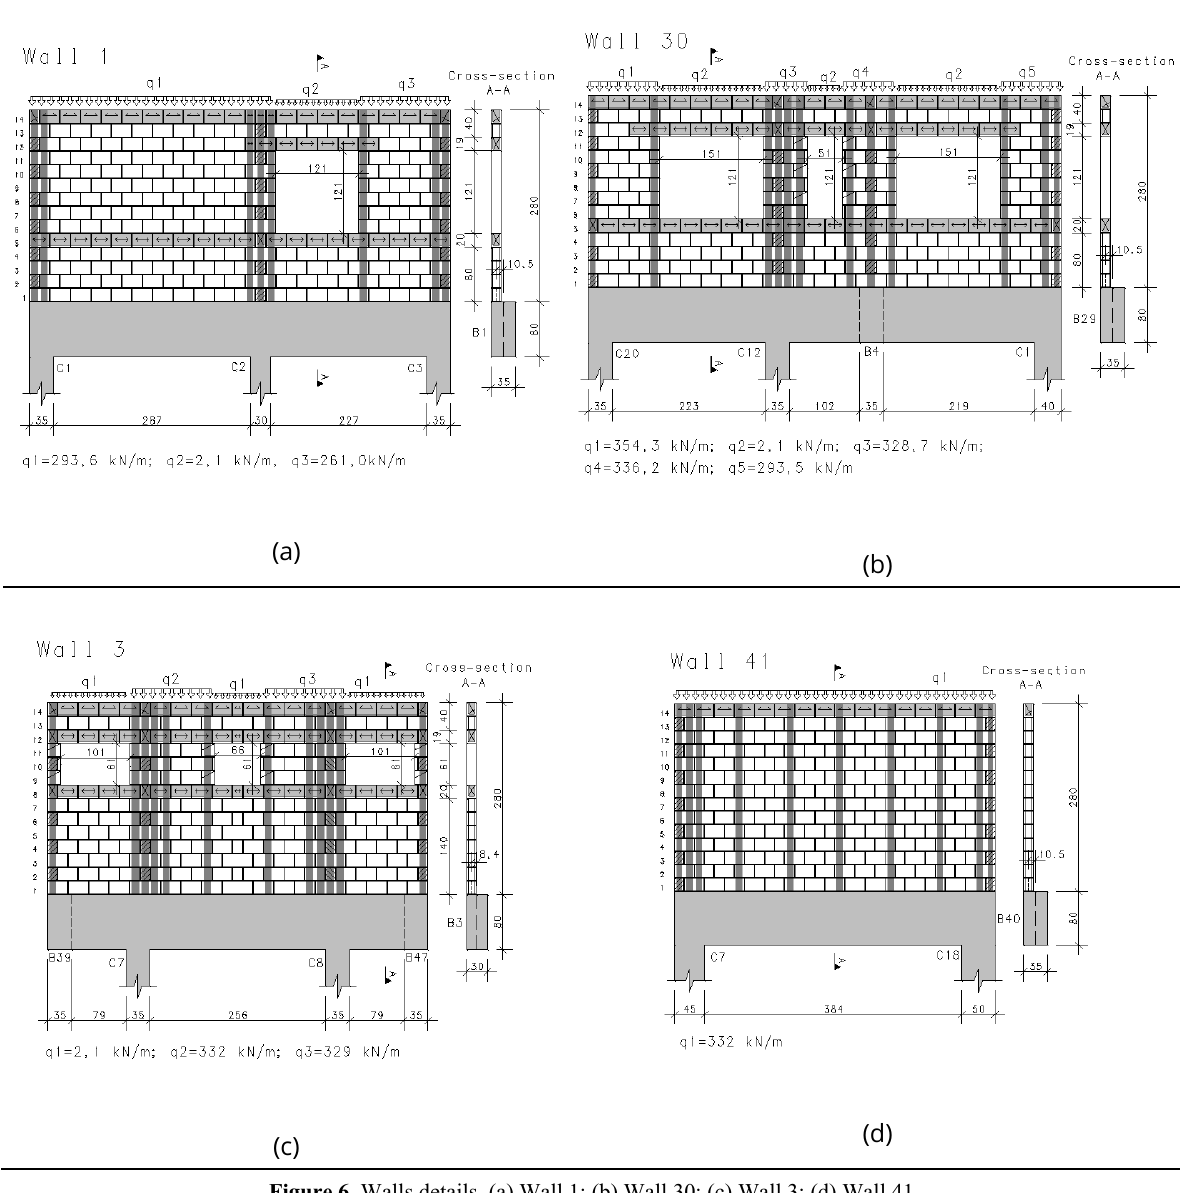
Table 4. Maximum forces and displacements in the support beam of Wall 1.